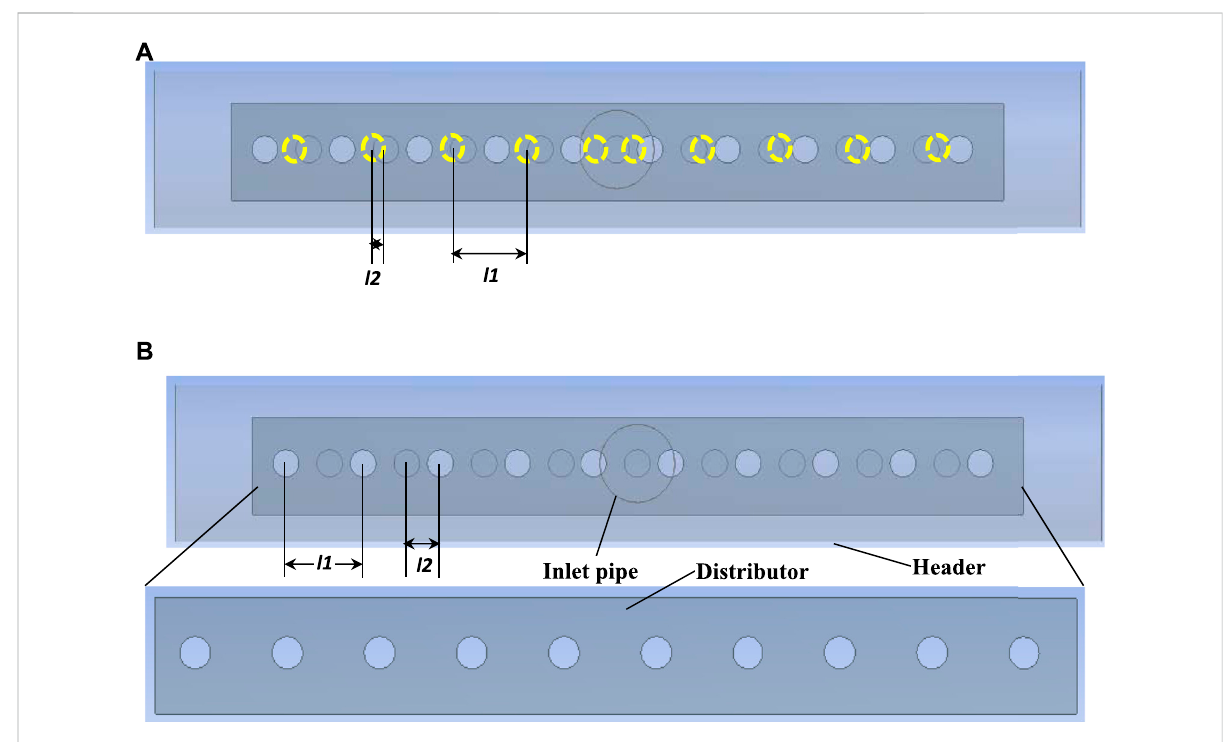
FIGURE 6 Geometricaldetails oftheheader and distributor along with parametersfor con fi guration selection. (A) Con fi guration 1 and (B) con fi guration 5.